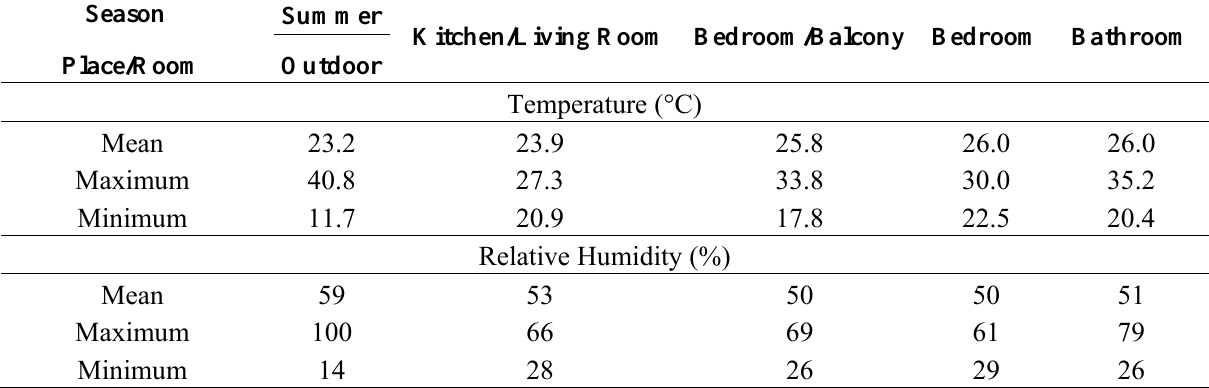
Table 1. Comparison of outdoors and indoors air temperature and relative humidity values in case study 1 during summer season. Season Summer Kitchen/Living Room Bedroom/Balcony Bedroom Bathroom Place/Room Outdoor